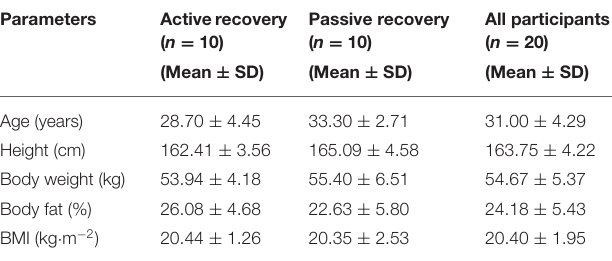
TABLE 1 | Anthropometric data.